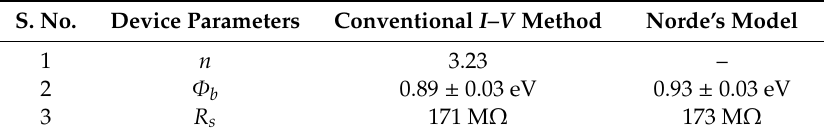
Table 2. Comparison of various parameters of the Ag / PFB / p-Si device extracted from the conventional I - V and Norde’s techniques.